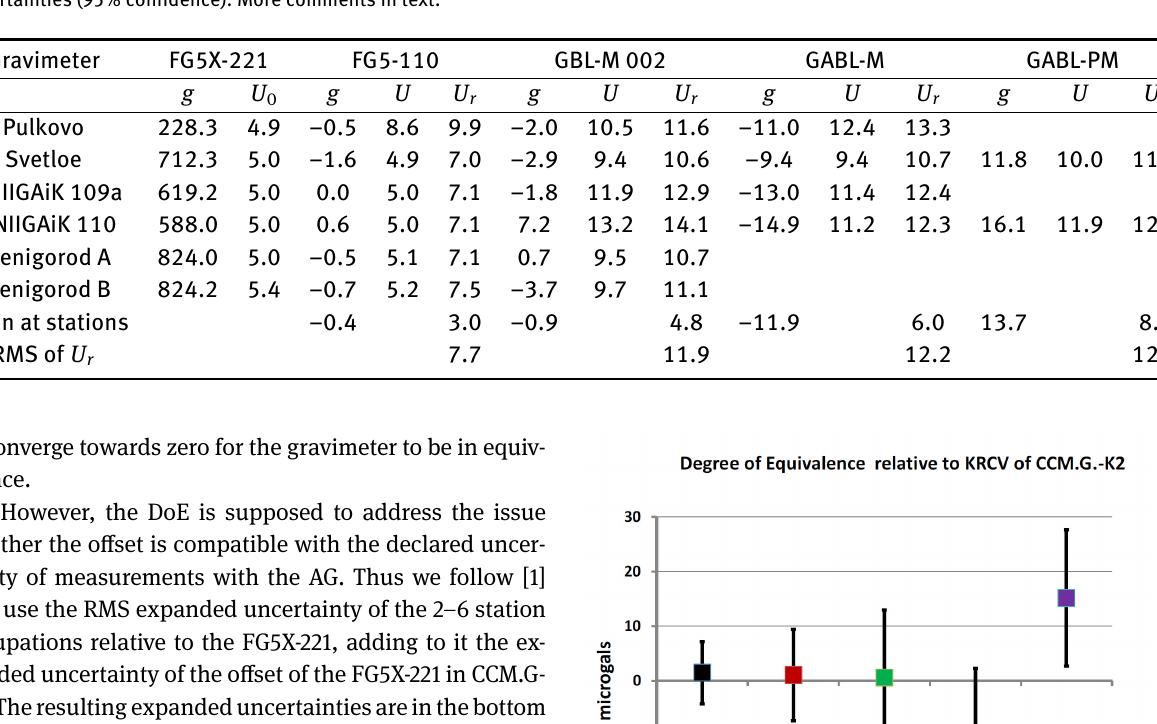
Table 6: The station-by-station results of the RFCAG2013. The columns labelled “ g ” give the results of the AGs at the stations at 1 m height. The last digits of the results of the FG5X-221 are shown; they are subtracted from the other gravimeters. The columns labelled “ U ” ( U for 0 the FG5X-221) give the uncertainties of the results. The columns labelled “ U ” give the uncertainties of the difference between the AG and r the FG5X-221, calculated from U . The first row below the station rows gives in the “ g ” column the weighted mean of the r = [ U 2 + U 2 0 ] 1/2 2–6 differences between the AG and the FG5X-221, with the (1/ U of the station rows as weights. The “ U ” column in this row gives the r ) 2 r uncertainty of the difference. The lowest row gives the RMS of the 2–6 values U . All units are microgals and all uncertainties are expanded r uncertainties (95% confidence). More comments in text.